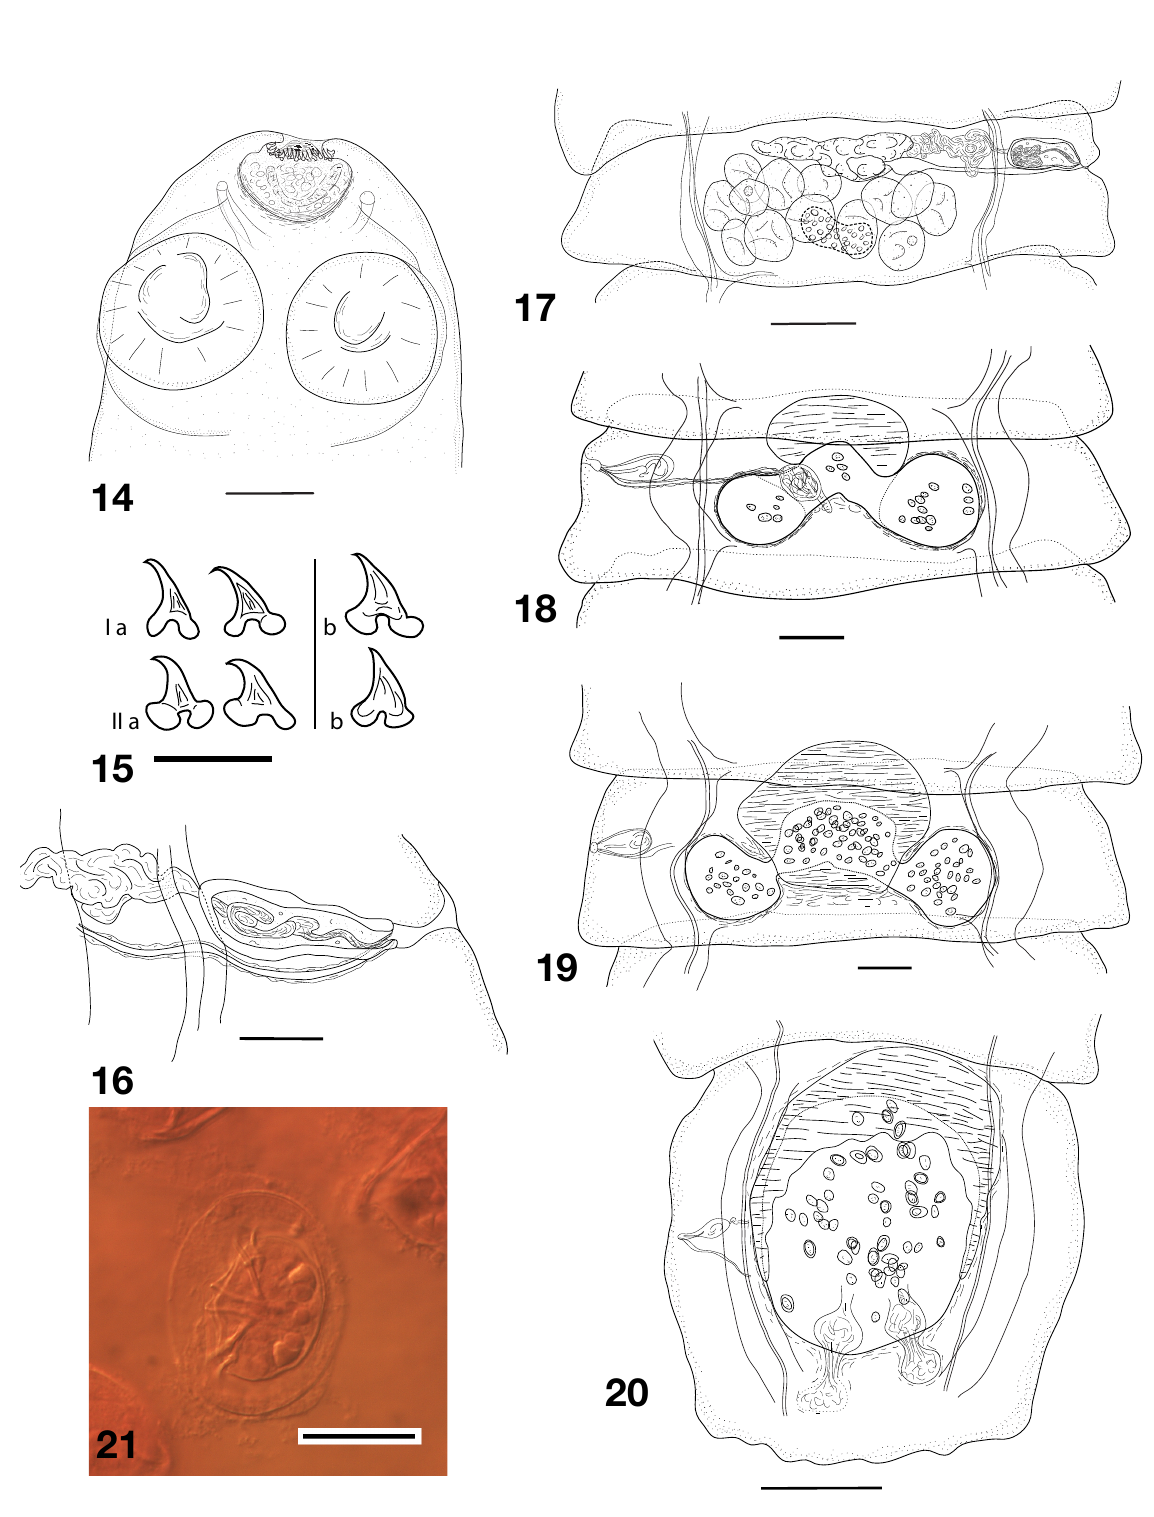
Figs 14-21. Biuterina jensenae sp. nov. 14 . Scolex; 15 . Rostellar hooks (I: anterior, II posterior); 16 . Figs 14–21. Biuterina jensenae sp. nov. 14 . Scolex. 15 . Rostellar hooks (I: anterior; II: posterior; a: from Cirrus-sac; 17 . Mature proglottis, dorsal view; 18-20 . Various stages of paruterine organ holotype; b: from Tricholestes criniger (Blyth, 1845)). 16 . Cirrus-sac. 17 . Mature proglottis, dorsal development; 21 . Egg. Scale bars: 14, 17, 18, 19 = 100µm; 15 = 10 µm; 16 = 50µm; 20 = 250 µm; 1 = 20 µm. view. 18–20 . Various stages of paruterine organ development. 21 . Egg. Scale bars: 14, 17–19 = 100 µm; 15 = 10 µm; 16 = 50 µm; 20 = 250 µm; 21 = 20